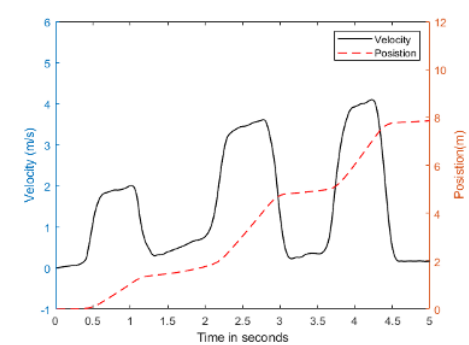
Fig. 7. The result of wavelet algorithm processing.